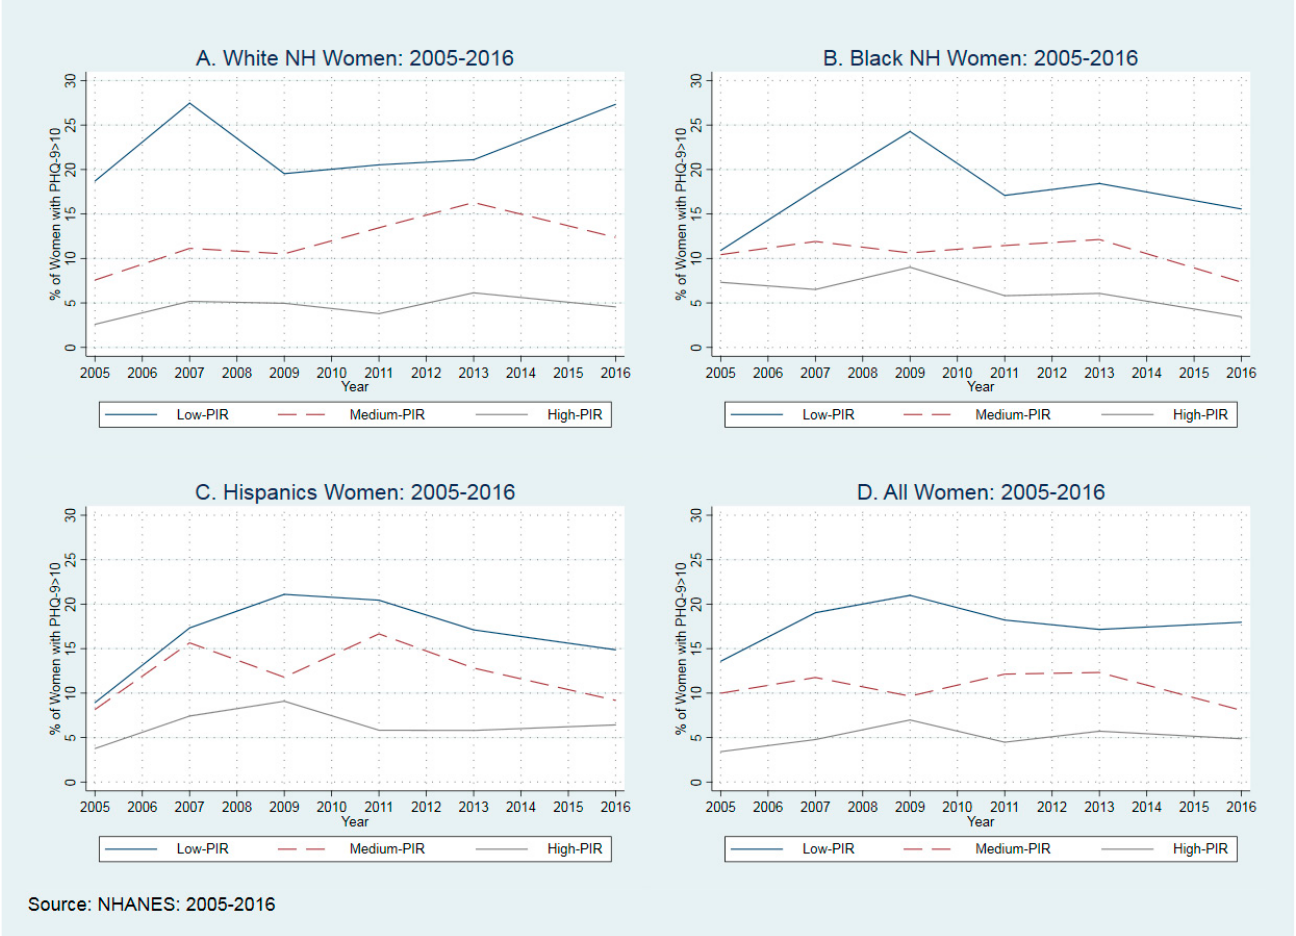
Figure 1. Distribution of Clinically Depressed Women among Race and Ethnicity between 2005–2016.